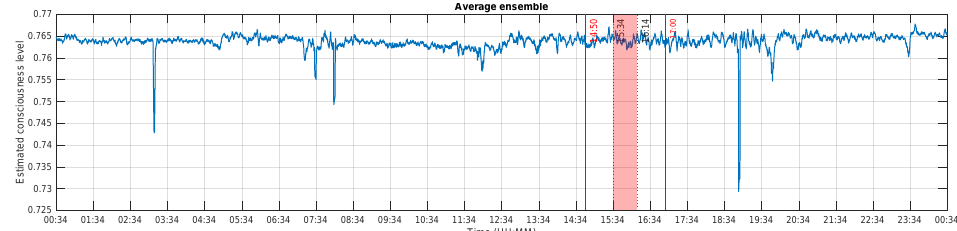
Figure 9. Consciousness level estimations for patient GR. The x-axis represents the recording times, while the y-axis displays the estimated consciousness levels. A value of 0 corresponds to unconscious- ness and a value of 1 means that the patient is conscious. The experiment was performed between 14:50 and 17:00 (vertical dotted lines). The red shade area represent the time frame ∆ t during which the experimenter reported that the patient was correctly answering the questions he was asked. The average value during all the recording is 0.7638, suggesting that the patient was conscious the whole time. An increase was also observed during the experiment (mean value of 0.7640) indicating an increase of the consciousness